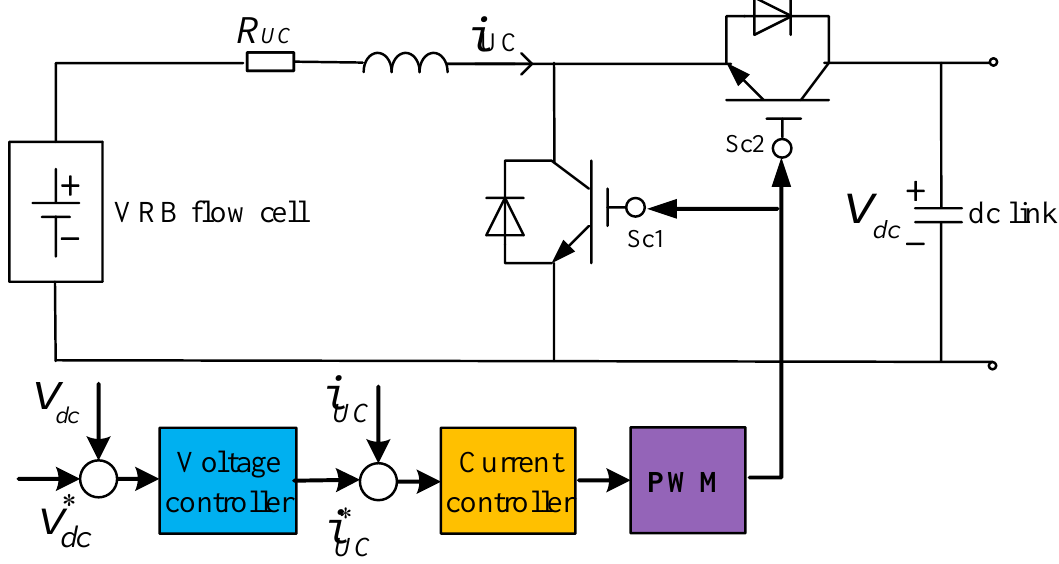
Figure 5. Configuration and control block diagram of the bidirectional buck-boost DC/DC